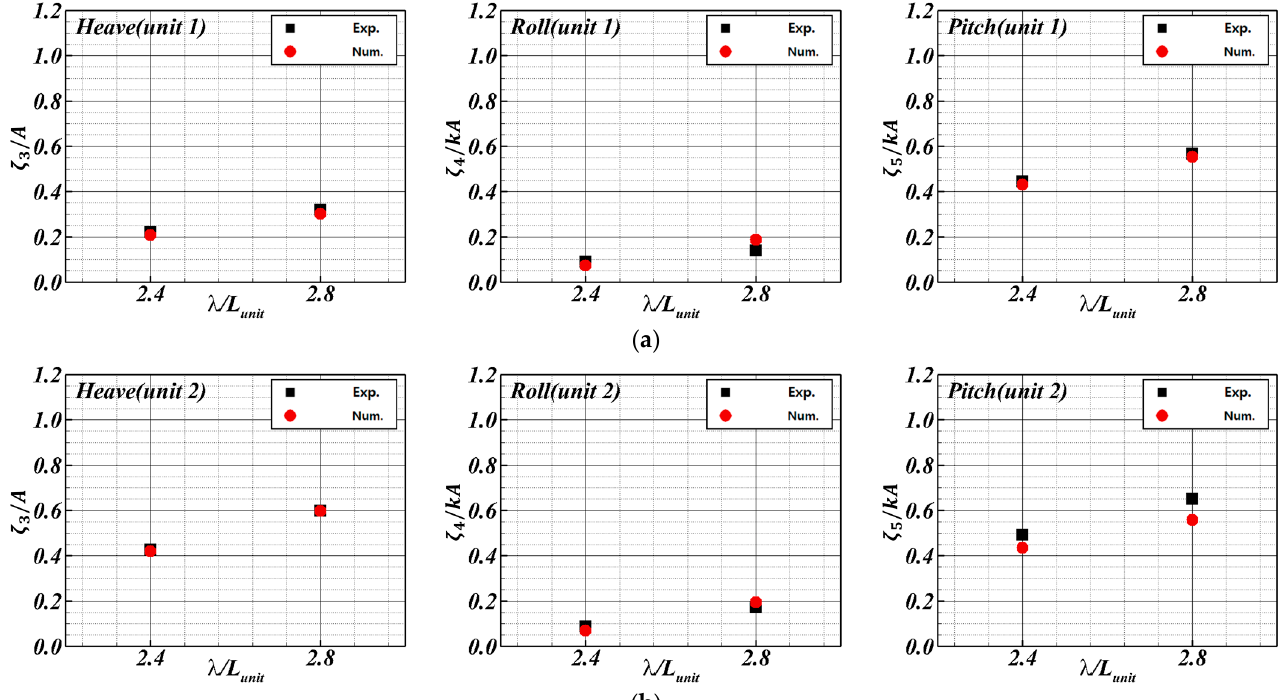
Figure 26. Wave pattern of experiment ( left ) and computation ( right ) according to the wavelength under oblique sea: ( a ) λ / L unit = 2.4; ( b ) λ / L unit = 2.8.